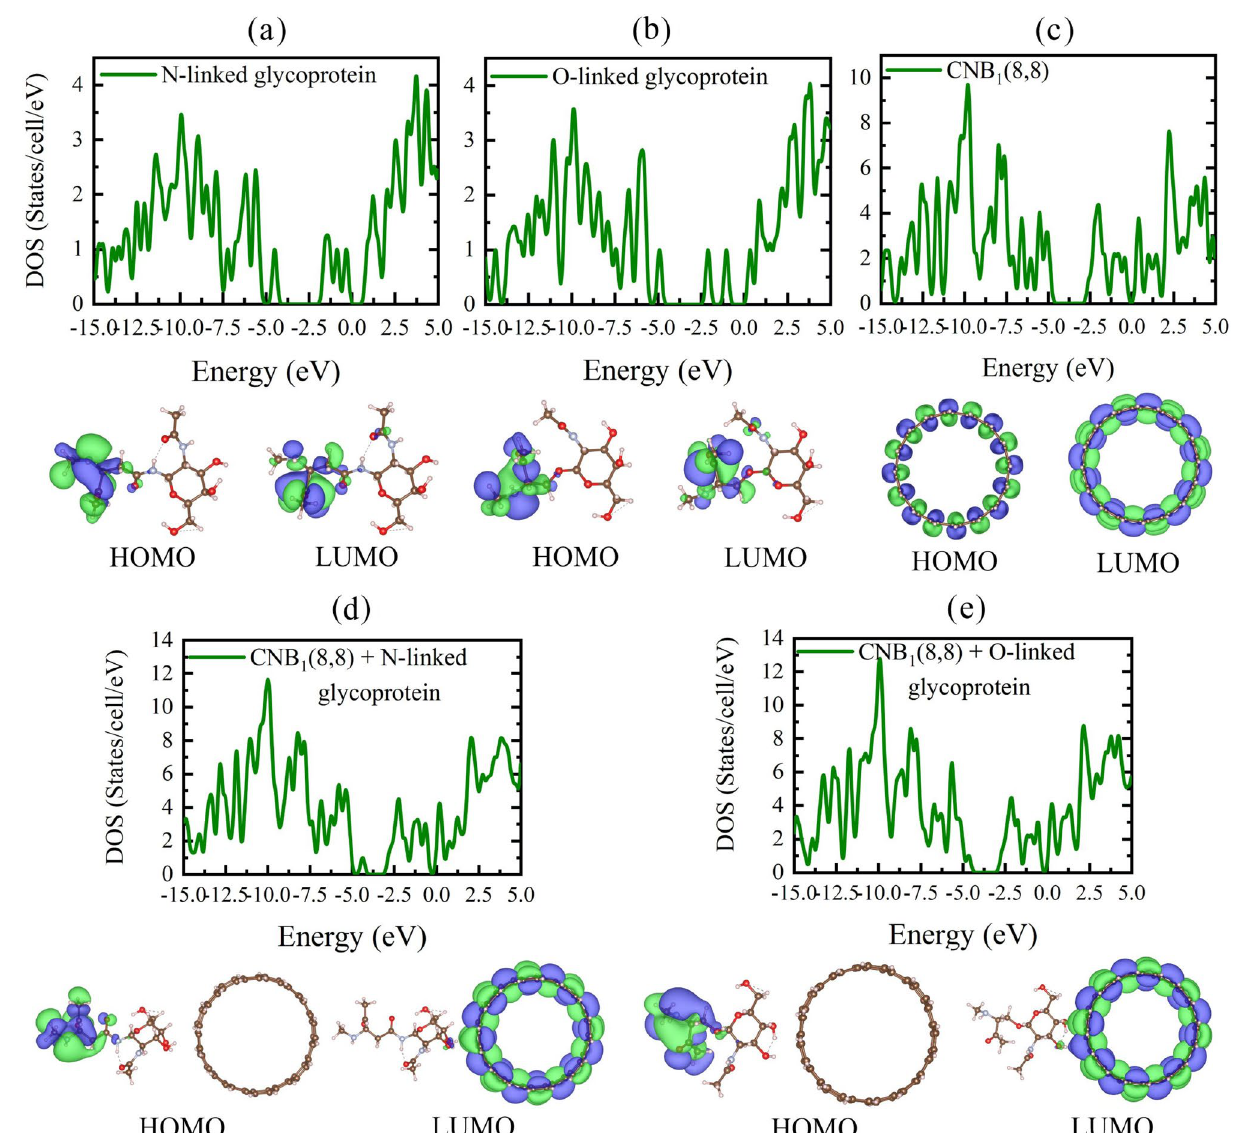
Figure 7. DOS, HOMO, and LUMO isosurface of ( a ): N-linked, ( b ): O-linked glycan molecules, ( c ): pristine CNB(8, 8), ( d ): CNB(8, 8) + N-linked, ( e ): CNB(8, 8) + O-linked glycan